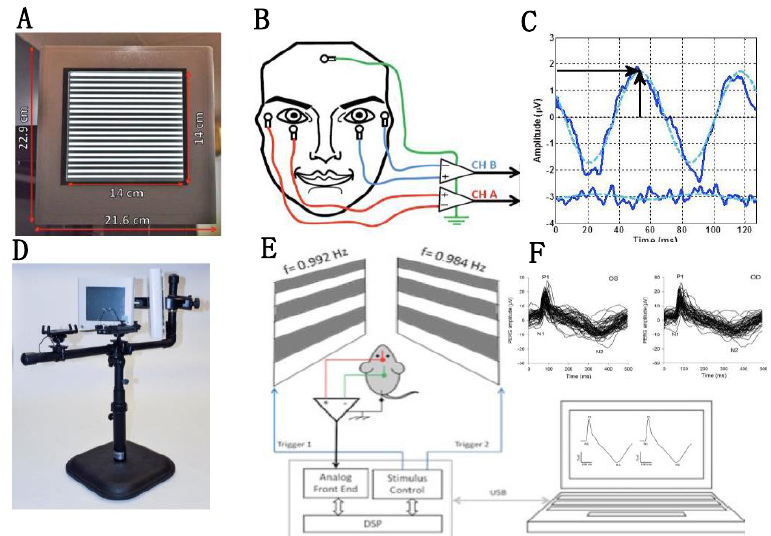
Figure 1. Recording set up for human and mouse PERG. ( A , D ) Patterned visual stimuli generated on LED tablets. ( B ) Surface electrode placement in human subjects for binocular PERG recording. ( C ) Example of human PERG and noise waveforms in response to fine gratings alternating 15.6 times/s. The blue dashed line superimposed to the PERG waveform represents the 15.6 Hz response component isolated in the frequency domain that is actually measured. Amplitude is measured from zero to the positive peak (vertical arrow), and latency is the corresponding time-to-peak (horizontal arrow). ( E ) Dual stimulus for binocular PERG recording in the mouse using subcutaneous needle electrodes in the snout and on the back of the head. ( F ) Example of mouse PERG waveforms response to large gratings alternating at slight different rates for each eye around 2 times/s. Amplitude is measured from the positive wave P1 to the negative wave N2, and latency is the time-to-peak of the positive wave P1. In the example, PERGs from different normal C57Bl/6J mice are superimposed to emphasize reproducibility. Figure panels are replotted from Monsalve et al., TVST 2017 and Chou et al., IOVS 2014.